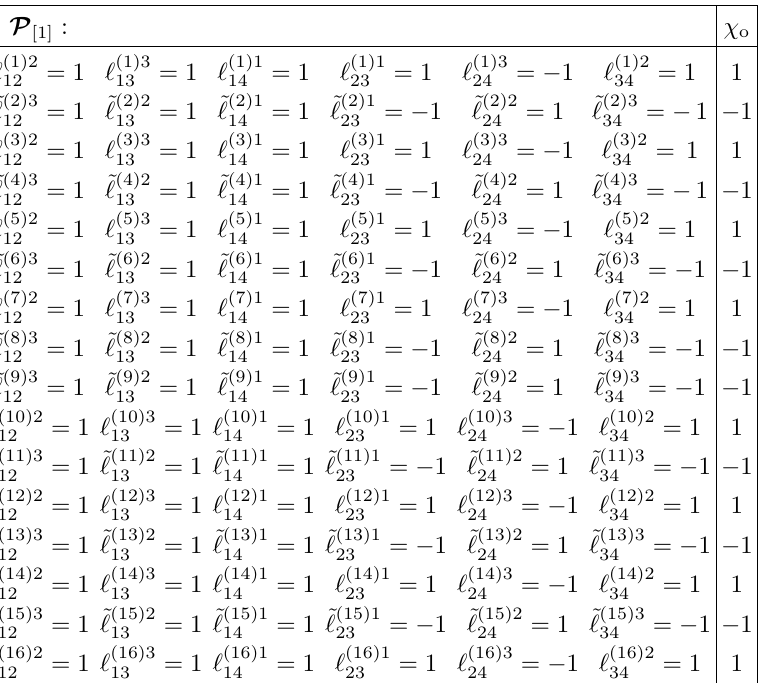
Table 11 . Non-vanishing ‘ , e ‘ , and (cid:31) o values for representation P